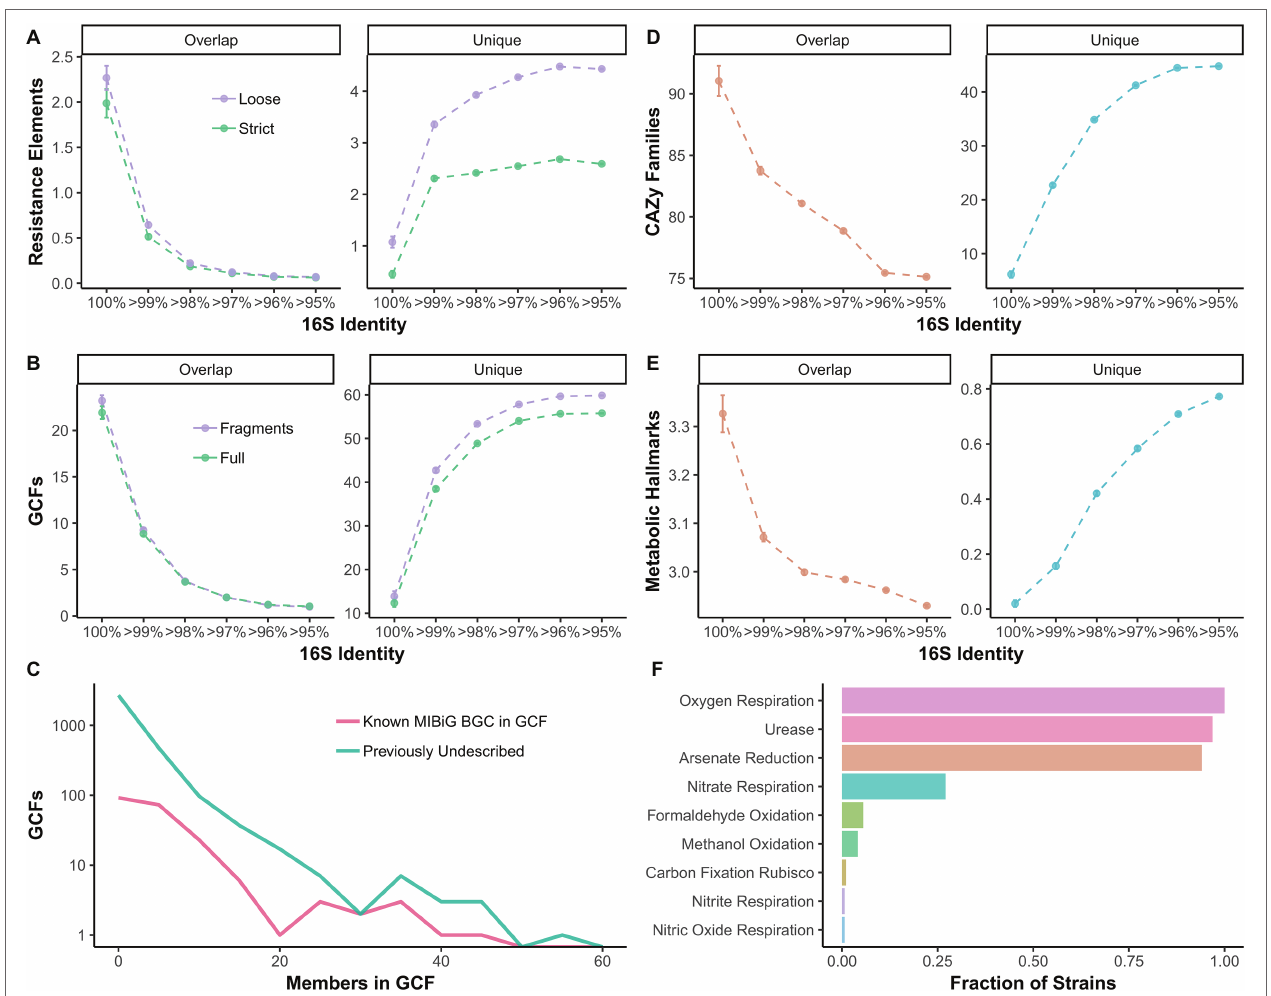
FIGURE 4 | Overlap between strains and unique between strains (A) resistance elements, (B) biosynthetic gene cluster (BGC) families, (D) carbohydrate-active enzyme families, and (E) metabolic hallmarks compared to 16S identity thresholds. (A) Colors refer to stringency of CARD database matches, either loose or strict. (B) Colors refer to either full BGCs (BGCs with 0.5 kb or more flanking contig on both sides) or all BGCs including fragments. (C) Frequency of family sizes for gene cluster families. Colors signify whether GCF has a MIBiG match or is previously undescribed. (F) Fraction of Streptomyces strains with each metabolic hallmark (those with zero not